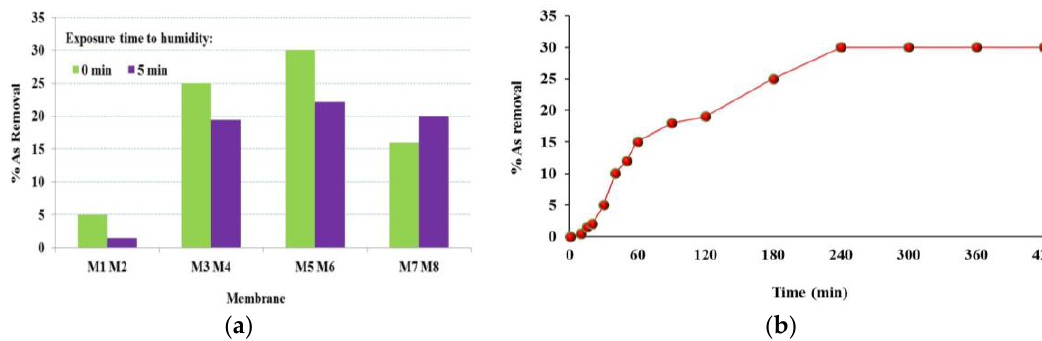
Figure 5. ( a ) As adsorption after 240 min test by using PES and PES–kaolin membranes prepared via NIPS and NIPS–VIPS; ( b ) Kinetic of As adsorption on the M5 PES–kaolin membrane.